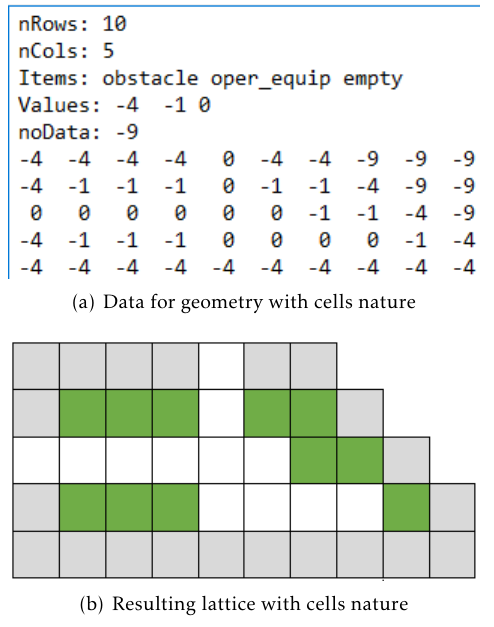
Figure 4. Illustration of data syntax for lattice construction is suitable for any lattice geometry. The same syntax can be used for attributes or any other parameters of interest.